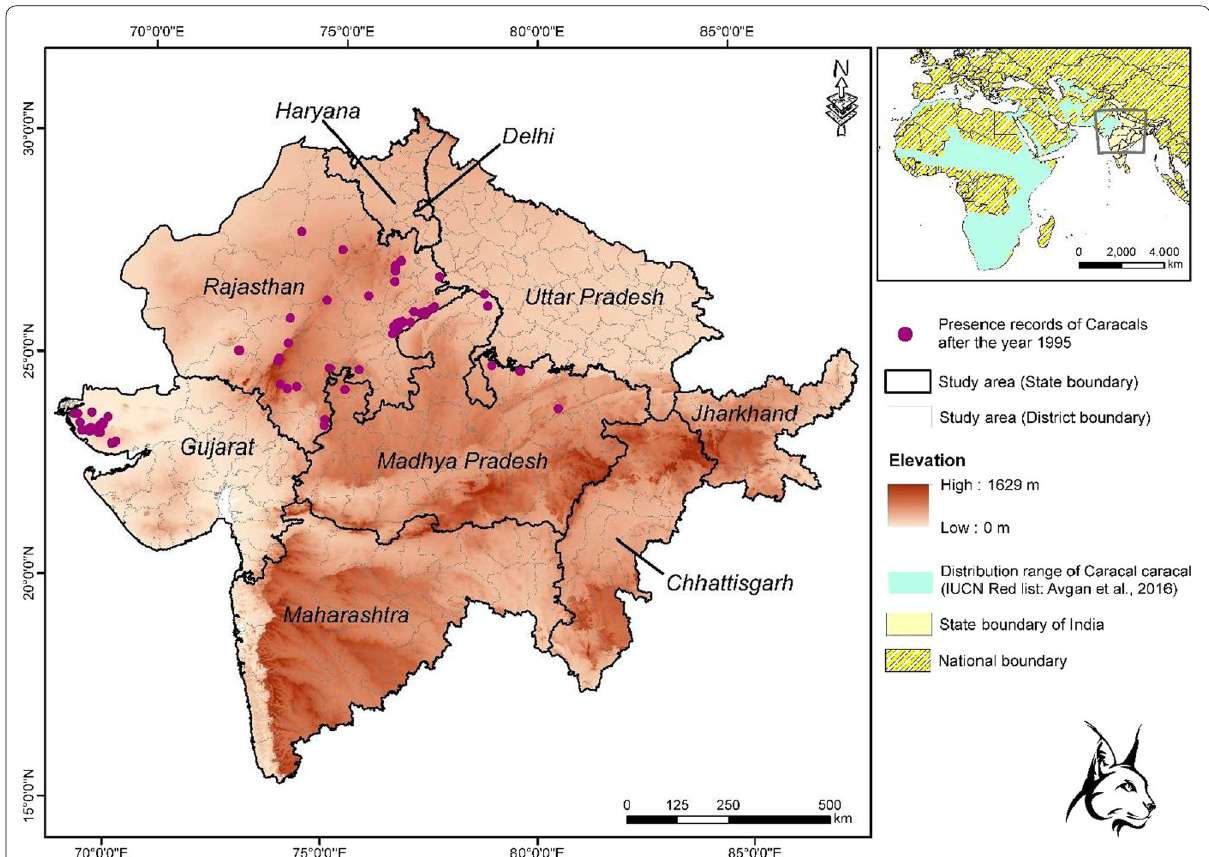
Fig. 2 Map showing the study area spread over the western and central Indian states with spatially thinned presence records of Asiatic caracals ( n 69) used for modeling the habitat =